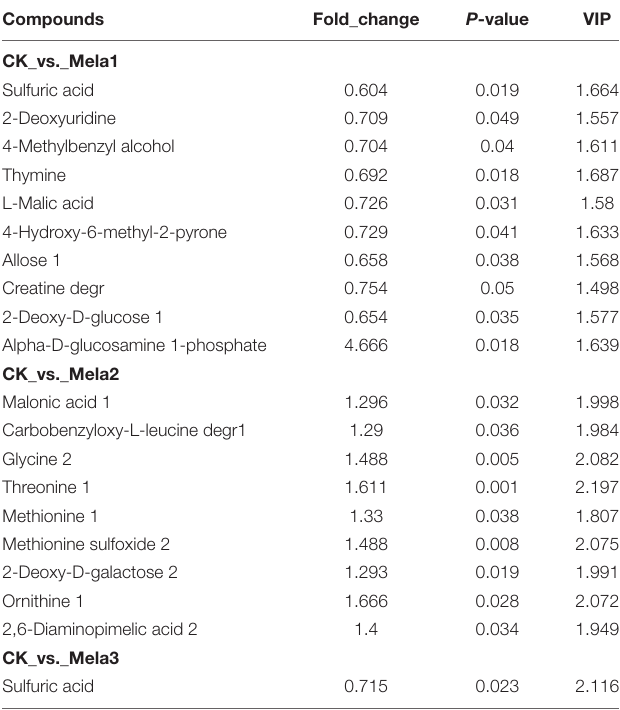
TABLE 2 | Candidate silage metabolites that were different between the CK and melatonin-treated groups. Compounds Fold_change P